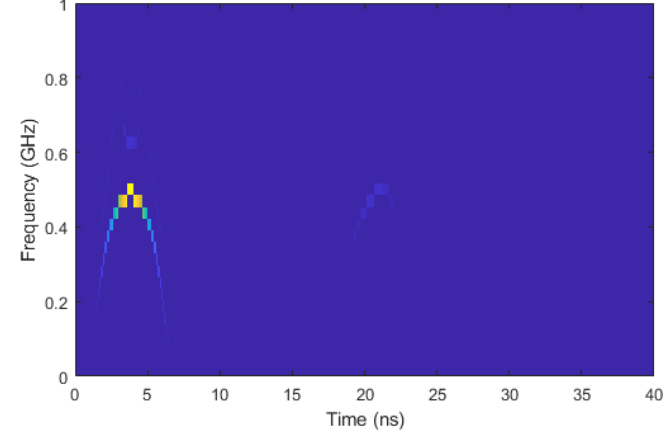
Figure 8. Time-frequency section of GPR.